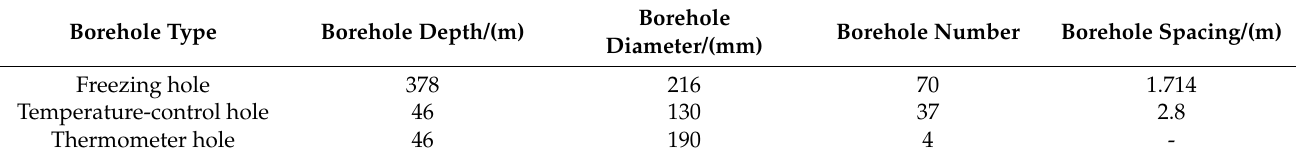
Table 1. Drilling